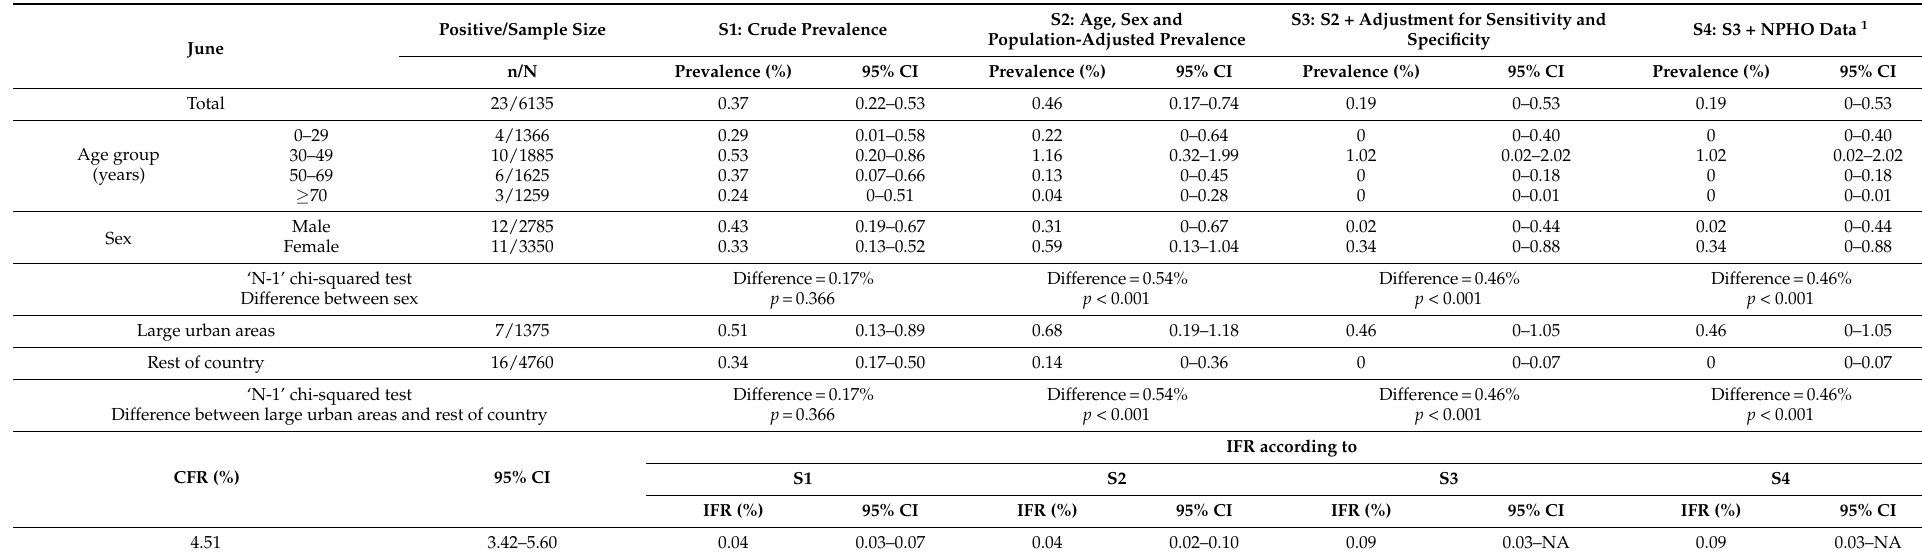
Table 2. Anti-SARS-CoV-2 IgG antibody seroprevalence, Greece, June 2020 ( n =